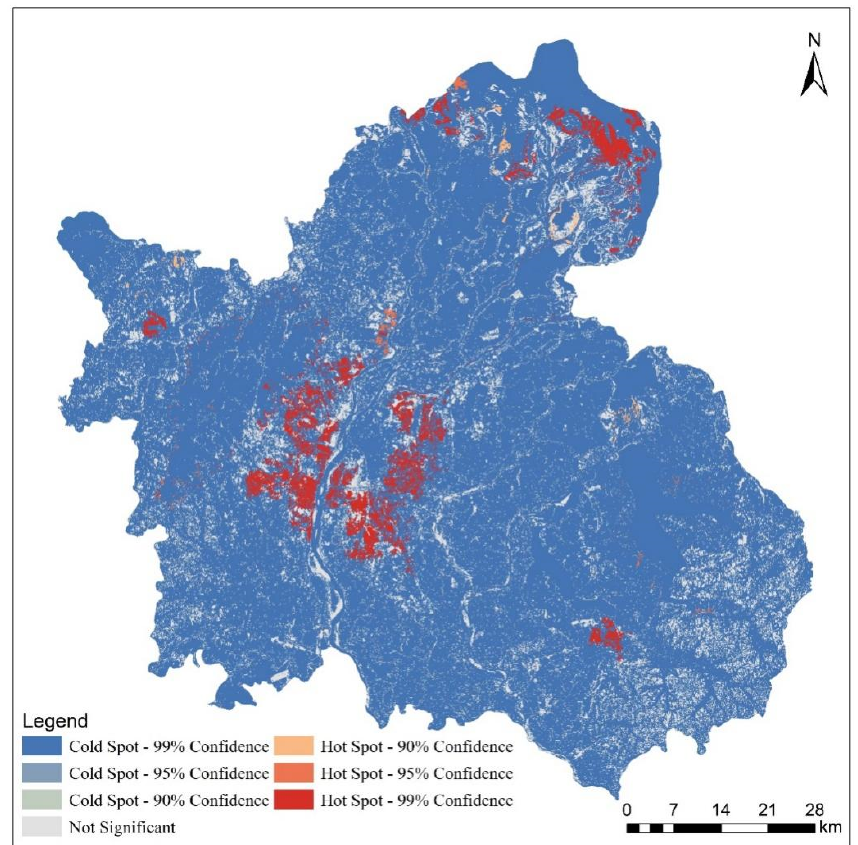
Figure 11. Hot spot of land use change from 2000 to 2020.